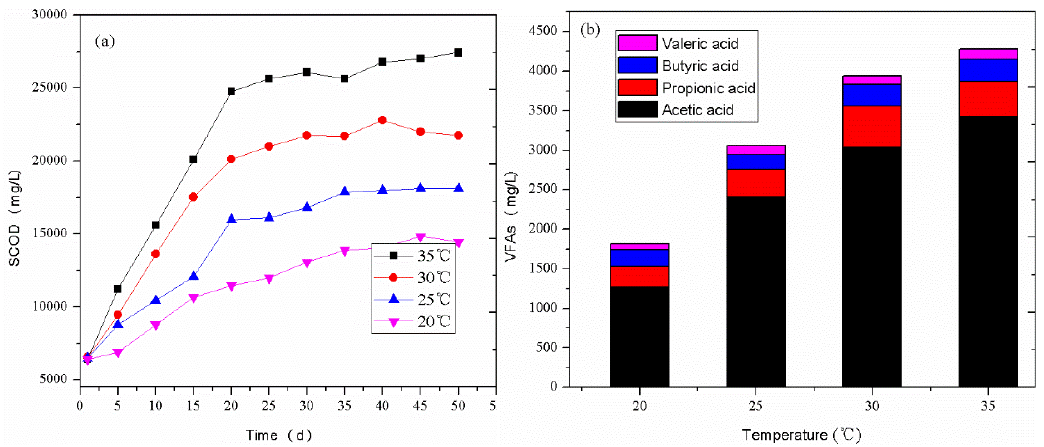
Figure 2. The concentration of solluted chemical oxygen demand (SCOD) ( a ) and volatile fatty acids (VFAs) ( b ) at different temperatures in the acidogenic phase.